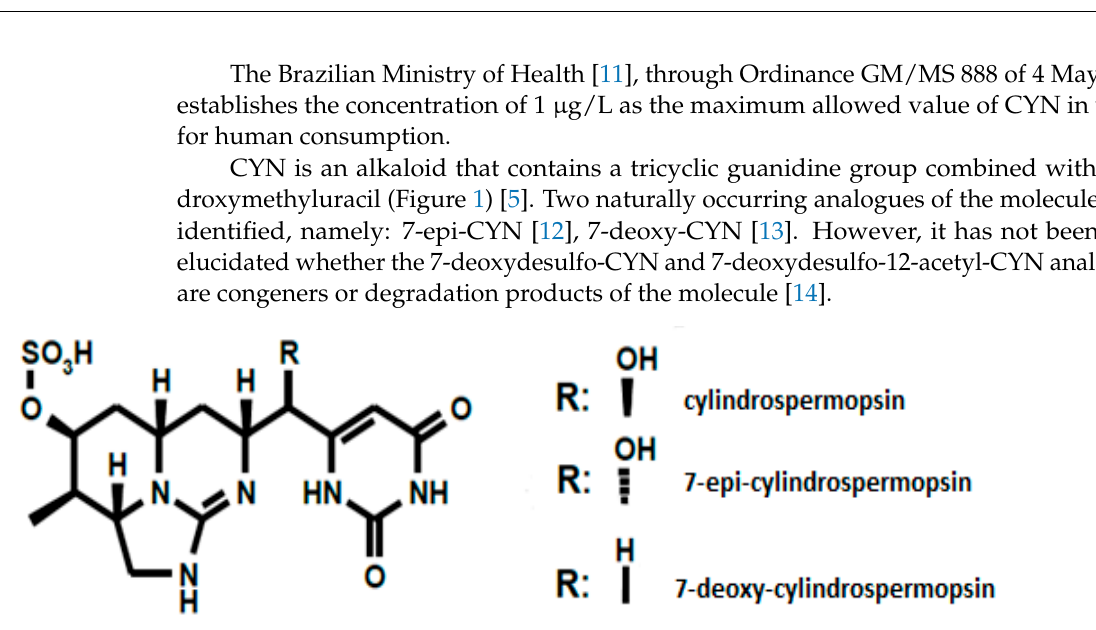
Figure 1. Molecular structure of common cylindrospermopsins. [10].